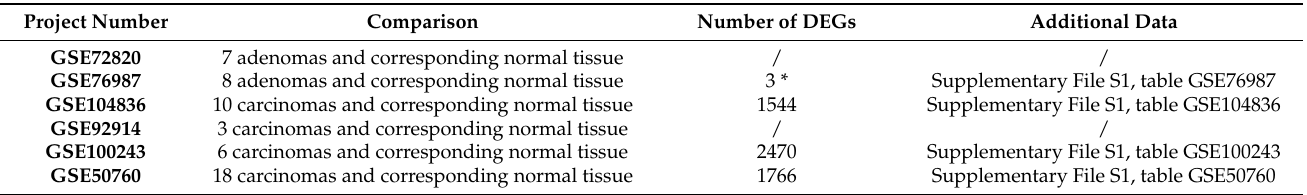
Table 1. Results of identification of differentially expressed genes (DEGs) on individual projects, including project number, comparison, number of DEGs, and additional